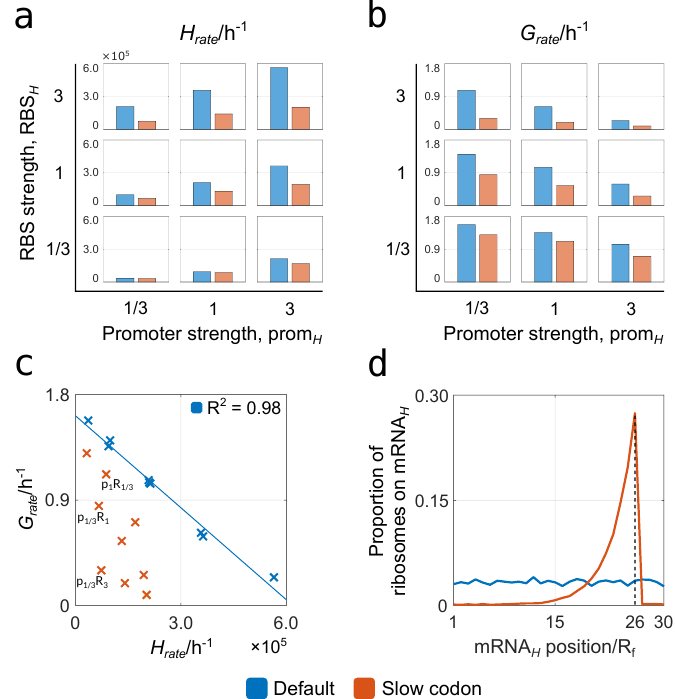
Figure 5. How gene construct design and inefficient codons affect performance. Blue represents the case when all codons on the gene construct have the same efficiency, while orange represents the case when a codon with lower relative efficiency (efficiency of 0.5% compared to the other codons) is introduced at position 26R f . All simulation results used a fixed nutrient quality of n = 100. ( a ) The effect of heterologous promoter and RBS strength on H rate . ( b ) The effect of heterologous promoter and RBS strength on G rate . ( c ) The relationship between G rate and H rate . Three results with similar H rate values are highlighted with relative values of prom (p) and RBS H (R) indicated. ( d ) Proportion H of ribosomes on mRNA H that are on each footprint position for a gene construct with low prom H = 1 (prom ) and high RBS H (RBS H = H 3